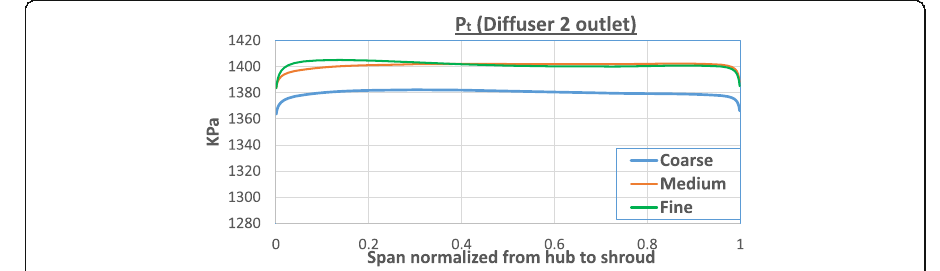
Fig. 4 Outlet total pressure for different grid